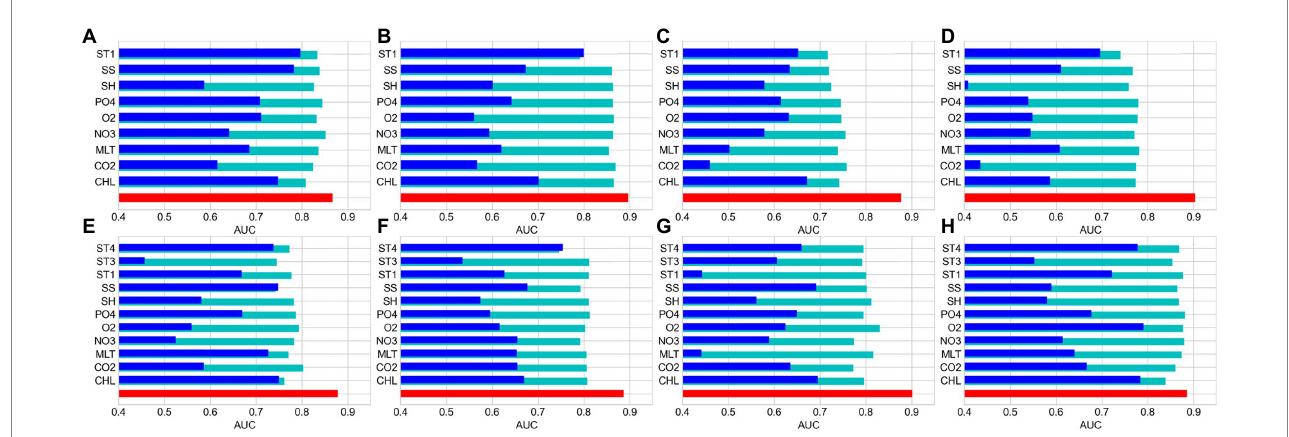
FIGURE 2 MaxEnt’s internal Jackknife test results on regularized training gain for reef-associated fish in the South China Sea (SCS) and East China Sea (ECS). (A–D) Winter, spring, summer, and autumn. (E–H) 1993–1999, 2000–2006, 2007–2012, and 2013–2019.